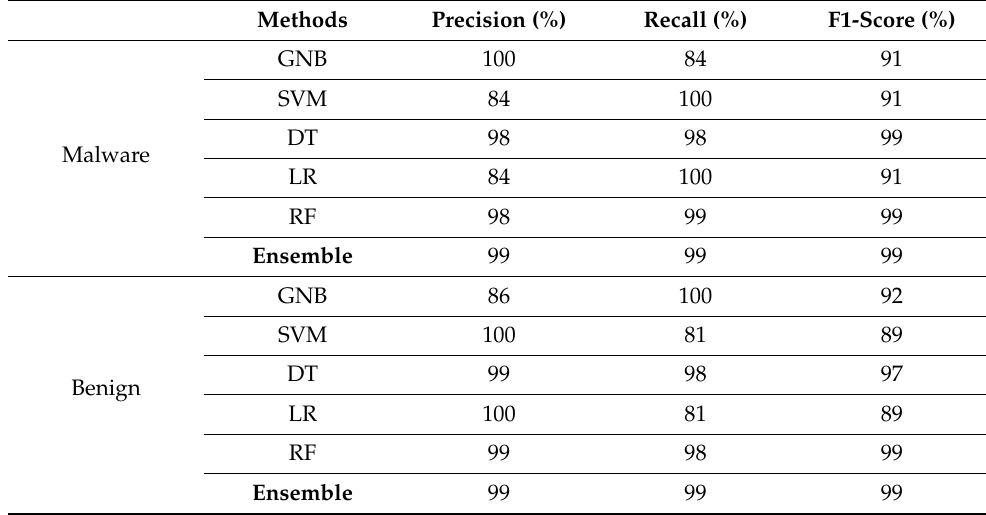
Table 3. Performance measures for malware detection using dataset 1.